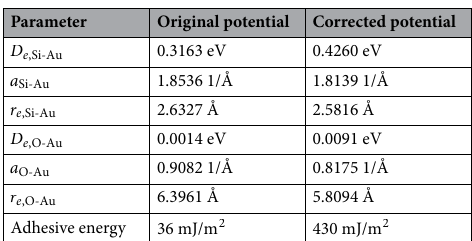
2 a ( r − r e ) − 2 e a ( r − r e ) parameters for Au–Si, and Au–O